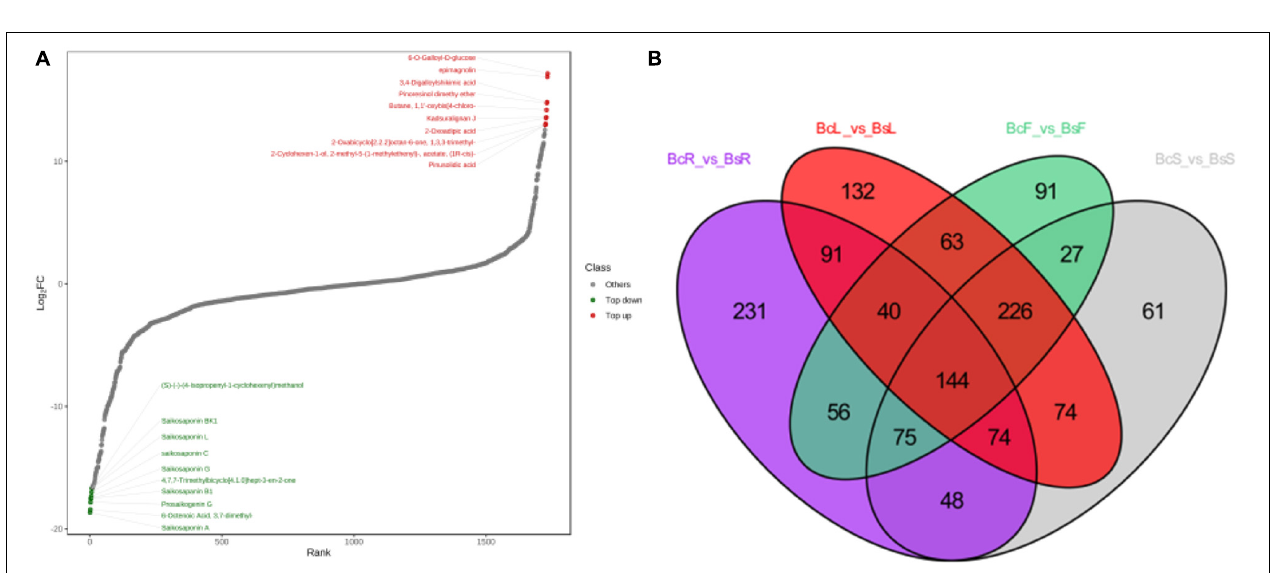
FIGURE 5 | The top 10 downregulated and upregulated metabolites in the BcR and BsR groups (A) . Venn diagram between different tissues showed the overlapping and accession-specific differential metabolites (B) .